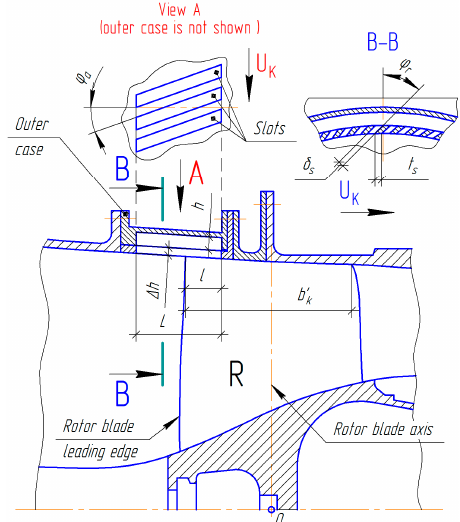
Figure 29. Slot type casing treatments. ( a ) Slot type CT; ( b ) two-row slot type CT; ( c ) R1 with slot type CT in assembly.